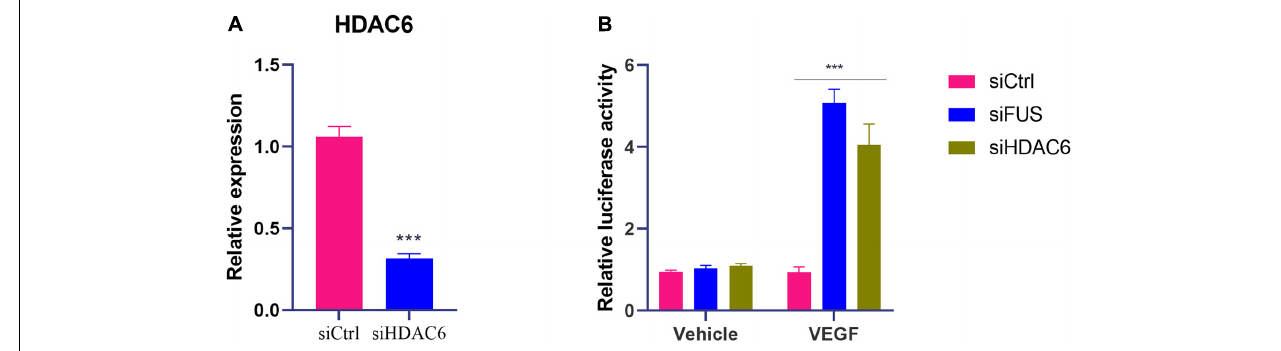
FIGURE 4 | Knockdown of HDAC6 or FUS enhances VEGF gene transcription in ox-LDL-treated HUVECs. (A) The mRNA level of HDAC6 in HUVECs transfected with control siRNA or HDAC6 siRNA. (B) VEGF gene promoter activity analyzed by relative luciferase reporter activities in HUVECs transfected with control siRNA, FUS siRNA, or HDAC6 siRNA. siCtrl, control siRNA; siFUS, FUS siRNA; siHDAC6, HDAC6 siRNA. N = 3. *** p < 0.001 vs. siCtrl